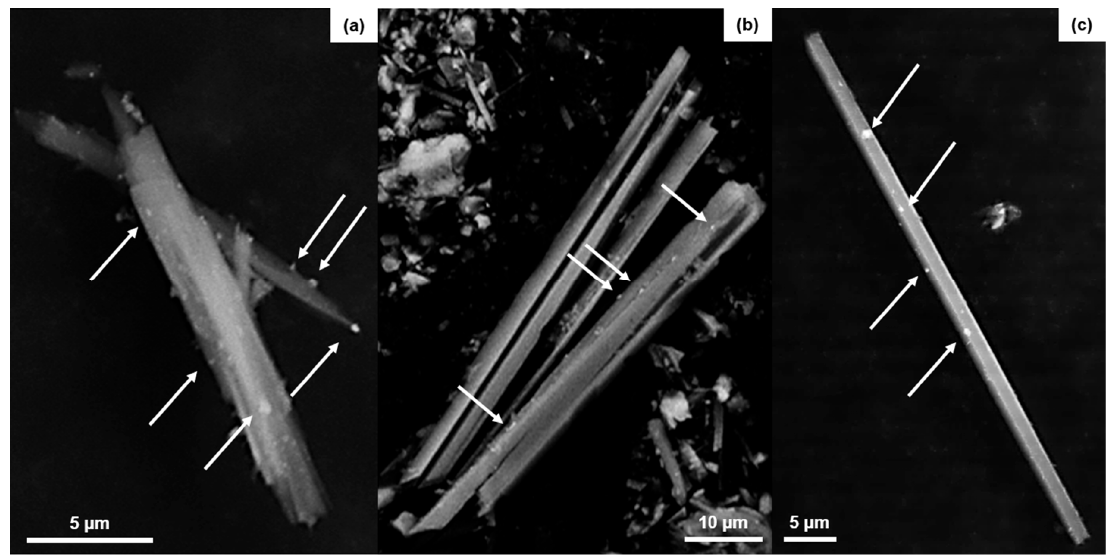
Figure 6. Backscattered scanning electron microscopy (SEM) images of erionite fibers from ( a ) Oregon, ( b ) Karlik, and ( c ) North Dakota. The arrows indicate particles lying on the crystal surfaces.